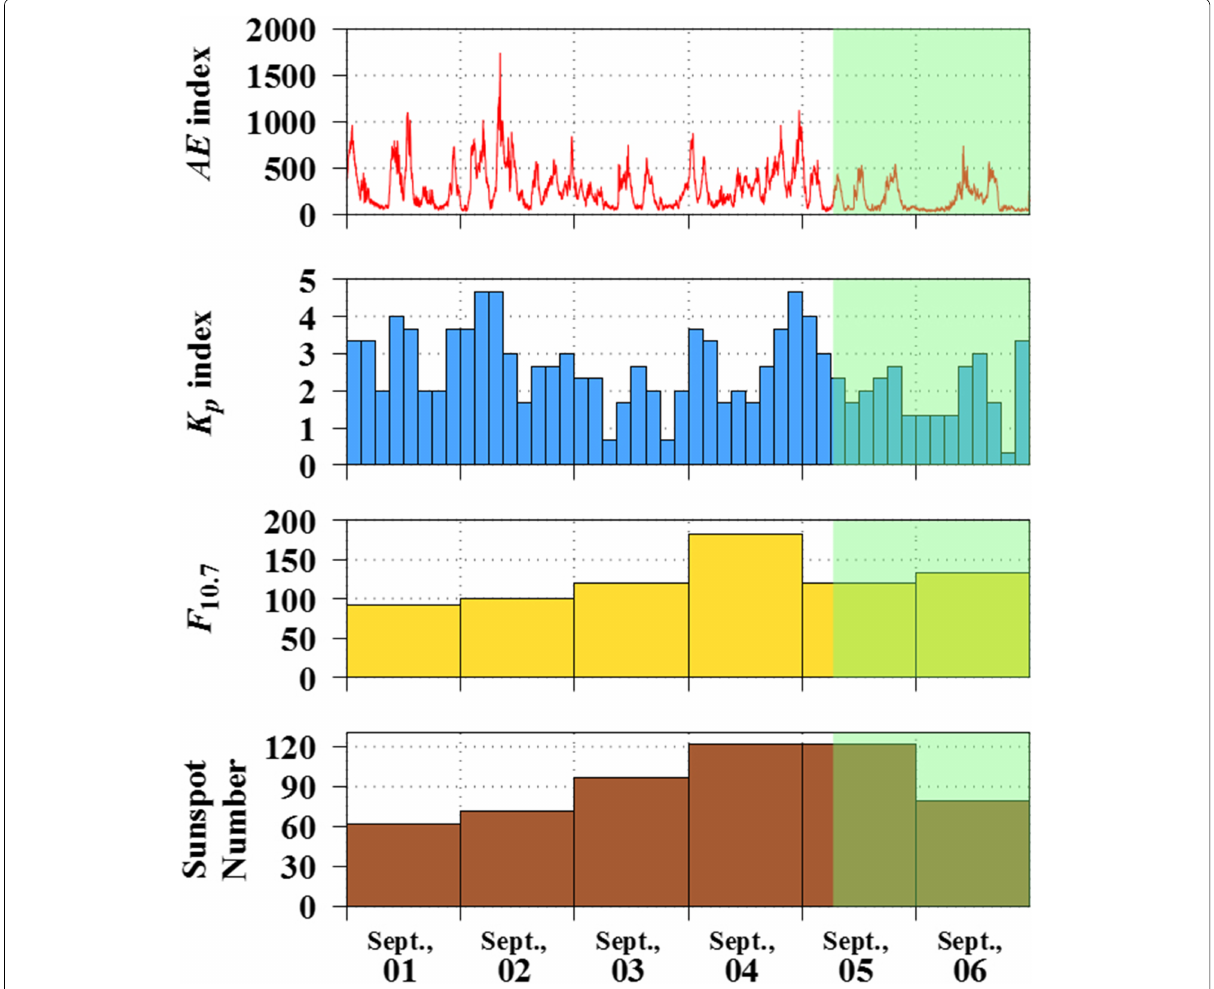
Fig. 1 Variations of sunspot number, solar flux F 10.7 , planetary index K p , and AE index during 1–6 September 2017. Green shaded area denotes the ionospheric measuring campaign period. Time is